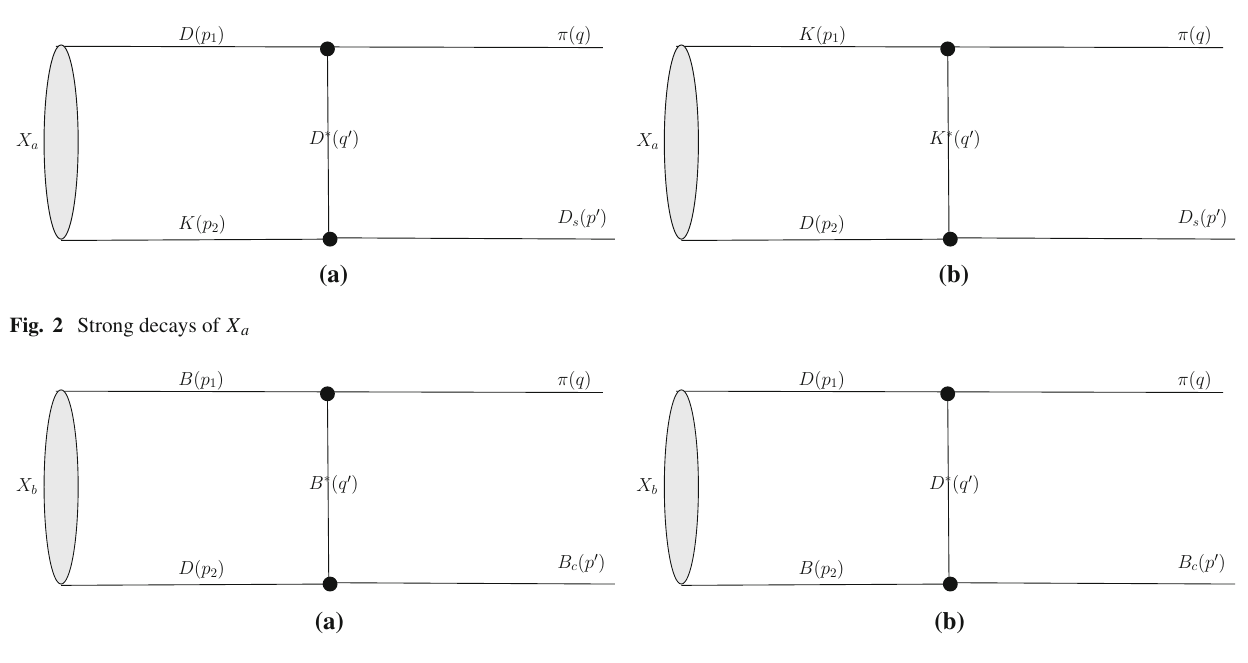
Fig. 3 Strong decays of X b